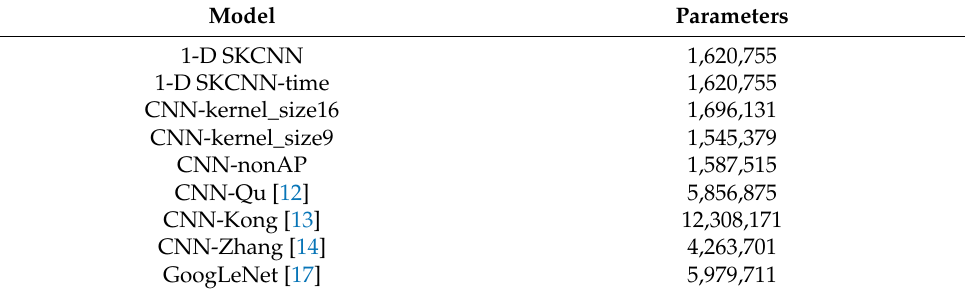
Table 3. The scale of parameter of the models in different